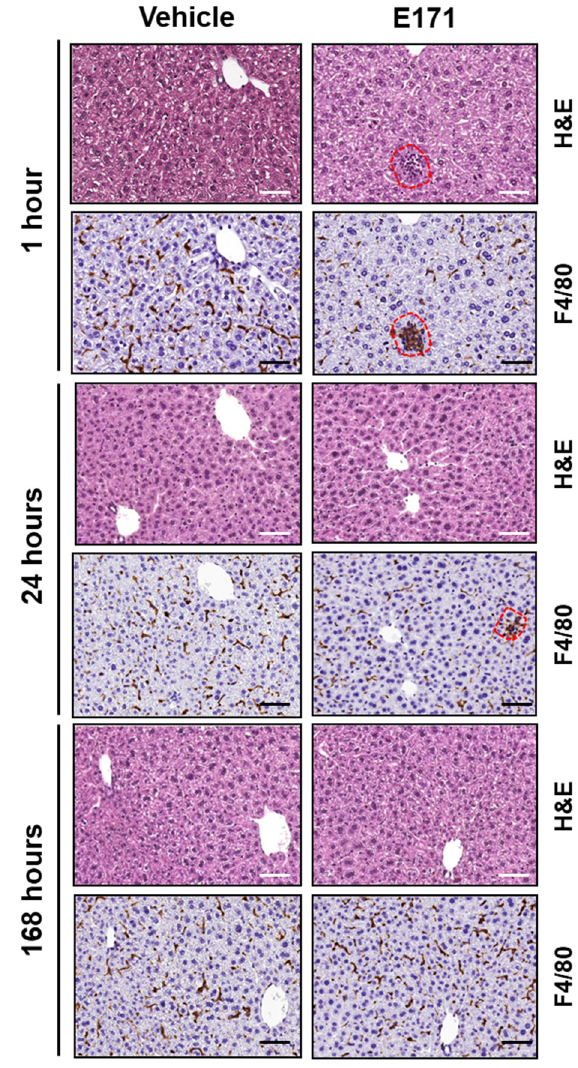
Figure 6. Pathological examination of livers of mice treated with E171. Representative images of liver hematoxylin–eosin (HE) and F4/80 immunostaining of mice injected with either vehicle or E171 and euthanized 1, 24, or 168 h after injection. Small microgranulomas were detected at 1 h and 24 h after E171 injection, but not at 168 h, indicative of low-grade transient inflammation due to E171. Scale bars = 50 μ m.